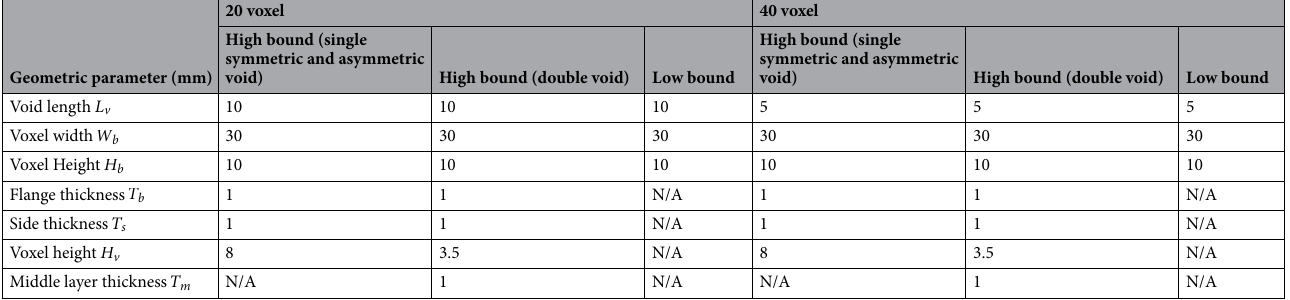
Table 2. The limits of the voxel geometric parameters for the beam models. The guidance on the meaning of the parameters refers to Fig. 4.